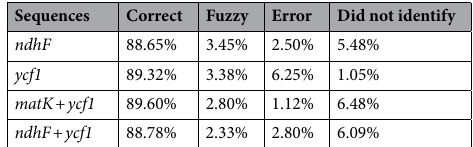
Table 5. Best Close Match test results based on genetic distance.